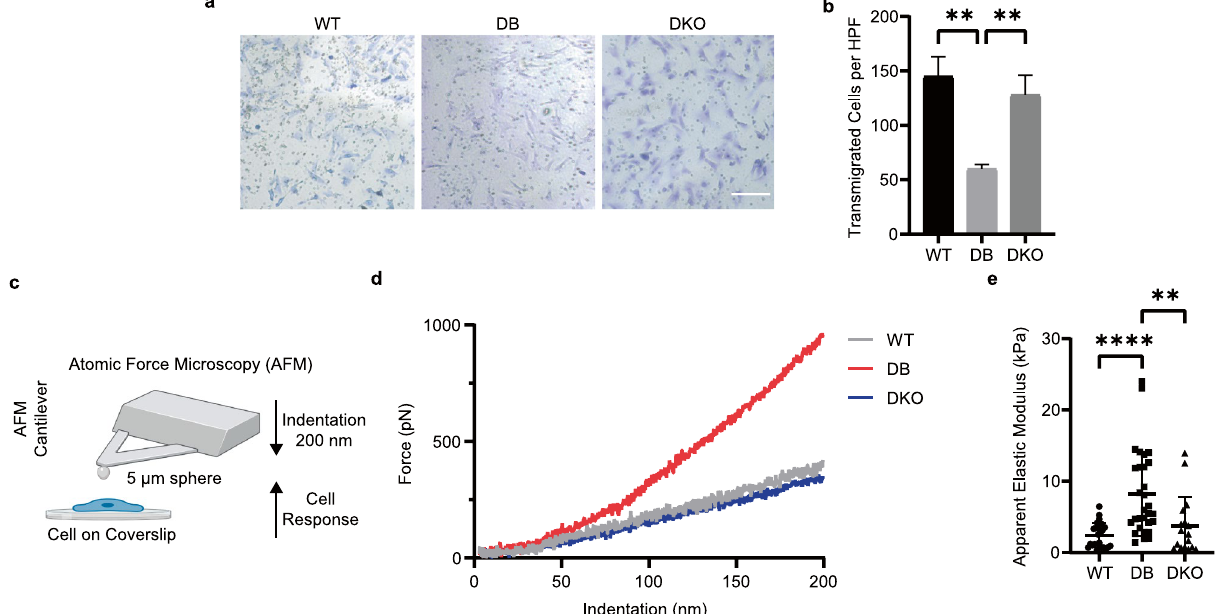
Figure 4. Diabetic fibroblasts have impaired migration and increased stiffness. ( a ) Representative IM images of transwell migration assay show fewer DB fibroblasts transmigrated after 24 h. Cells were stained purple. Scale bar = 200 μm. ( b ) Cell numbers per high power frame (HPF 20X objective) show fewer DB fibroblast transmigration. Data were collected by averaging 3 HPFs (n animals = 3 per genotype). One-way ANOVA followed by Tukey’s post hoc test and multiple comparison test. ***p < 0.001. ( c ) schematic (created with BioRender. com) shows an AFM test using a spherical tip. Image is not up to scale. ( d ) Representative force curves show differences during indentation. ( e ) Apparent elastic moduli calculated from Hertz Model show increased stiffness in DB fibroblasts. Data were collected by averaging 5 force curves per cell (n animals = 3 per genotype, n cells ≥ 6 per animal). One-way ANOVA followed by Tukey’s post hoc test and multiple comparison test. ****p < 0.0001. **p <